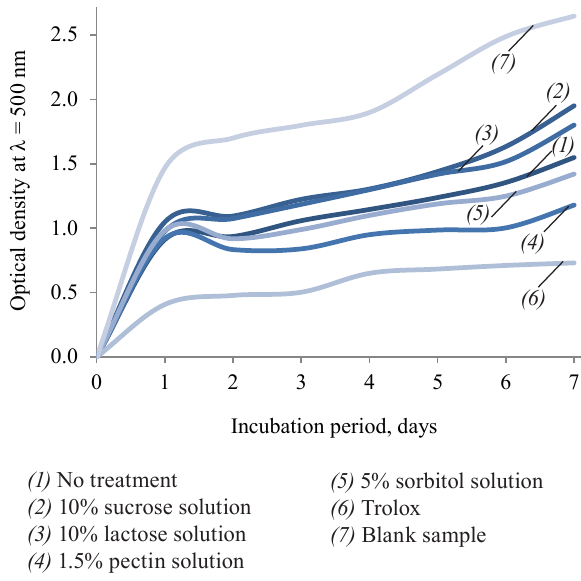
Figure 3 Effect of pre-treatment with cryoprotectors on the LPO inhibition of the freeze-dried